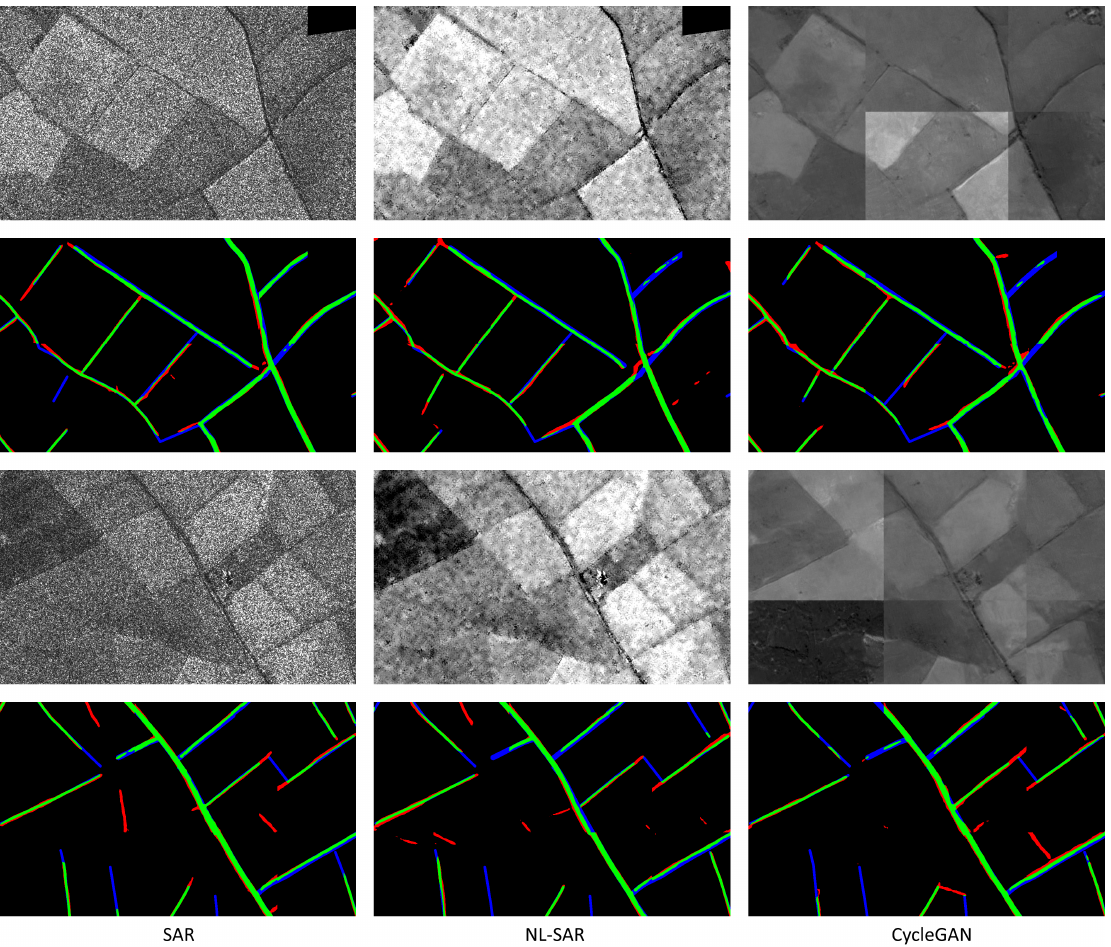
Figure 6. Binary road segmentation results of the DeepLabv3+ models trained on the SAR, NL-SAR and CycleGAN image data sets separately. Rows 1 and 3: image samples. Rows 2 and 4: segmentation confusion, colored as follows: green pixels are true positives, blue are false negatives, and red are false